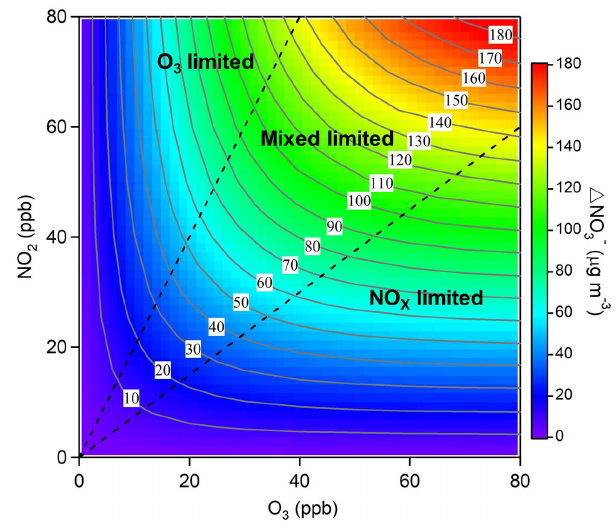
Figure 9. Contour plot of the model-simulated nighttime NO − formation as a function of the initial concentrations of NO 2 (0– 80ppbv) and O 3 (0–80ppbv). Note that the dashed lines are arti- ficially drawn to separate the three zones with a different sensitivity of nitrate formation to NO 2 and O 3